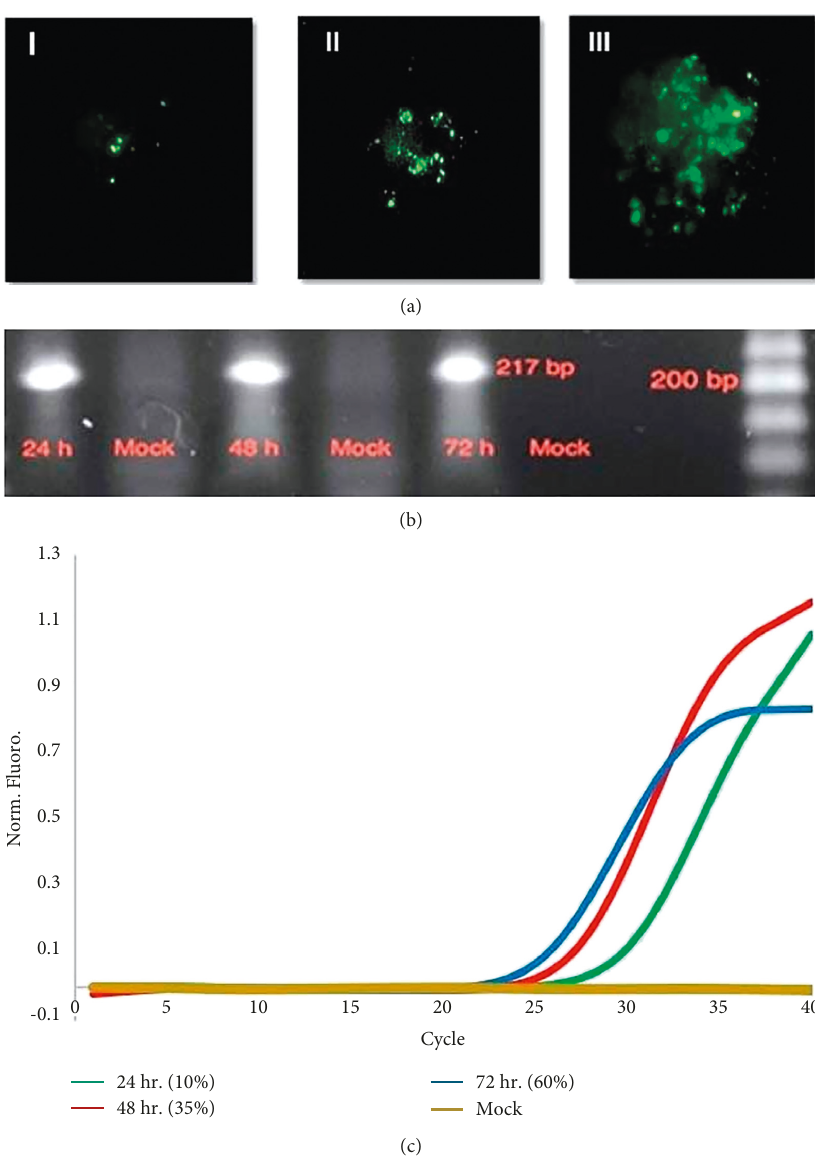
Figure 1: (a) Expression of GFP in NS1-transfected HEK-293T cells was examined by fluorescence microscopy at (I) 24hr (II) 48hr (III) 72hr posttransfection with 10x magnification and bar size of 25 μ m. (b) The expression of NS1 mRNA in HEK-293 Tcells was examined and visualized on 1.5% agarose gel at 100V for 40min and stained with GelRed at the indicated times posttransfection. (c) Posttransfection expression levels of NS1 mRNA overtime. Green: after 24hr, red: after 48 hr, blue: after 72hr, brown: mock-transfection at 24, 48, and 72hr